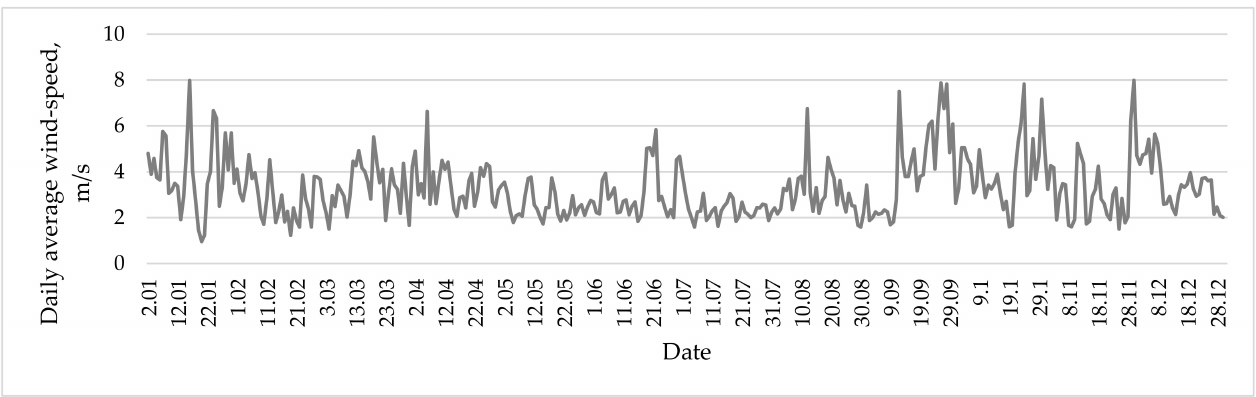
Figure 7. Hourly measured wind